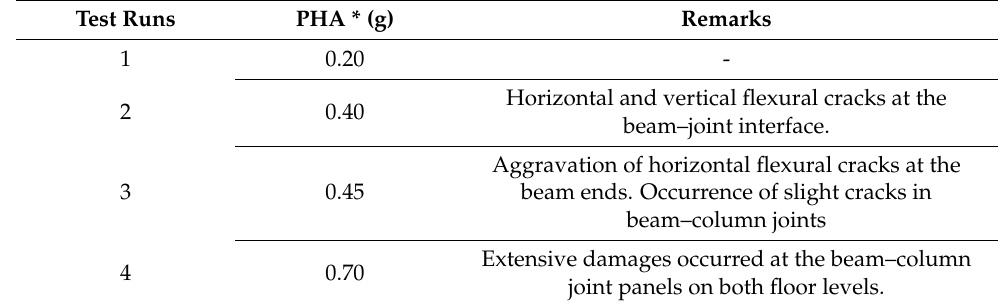
Table 3. Measured sustained maximum acceleration of base motions of the test frame.